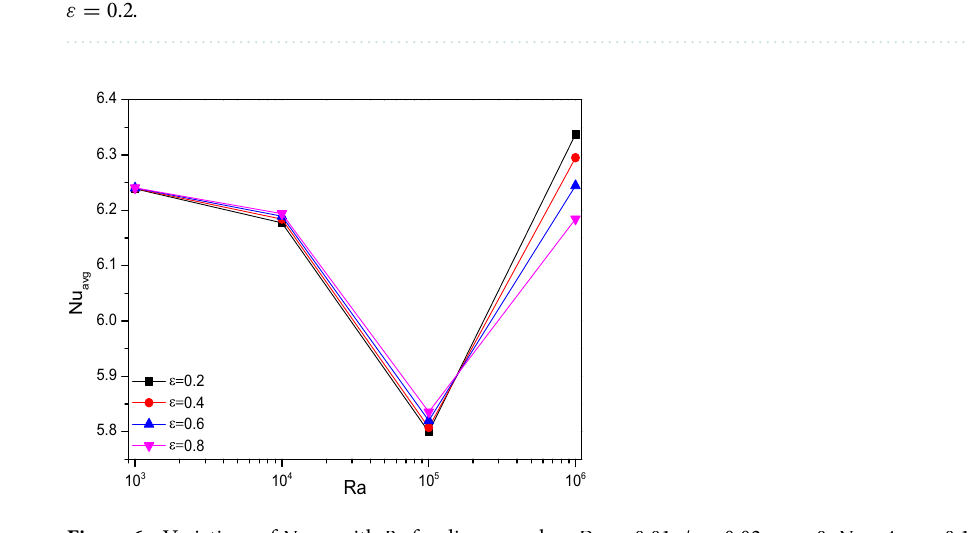
Figure 6. Variations of Nu avg with Ra for diverse ε when Da = 0.01 , φ = 0.02 , ω = 0 , N = 4 , r = 0.1, and Ha = 0 .